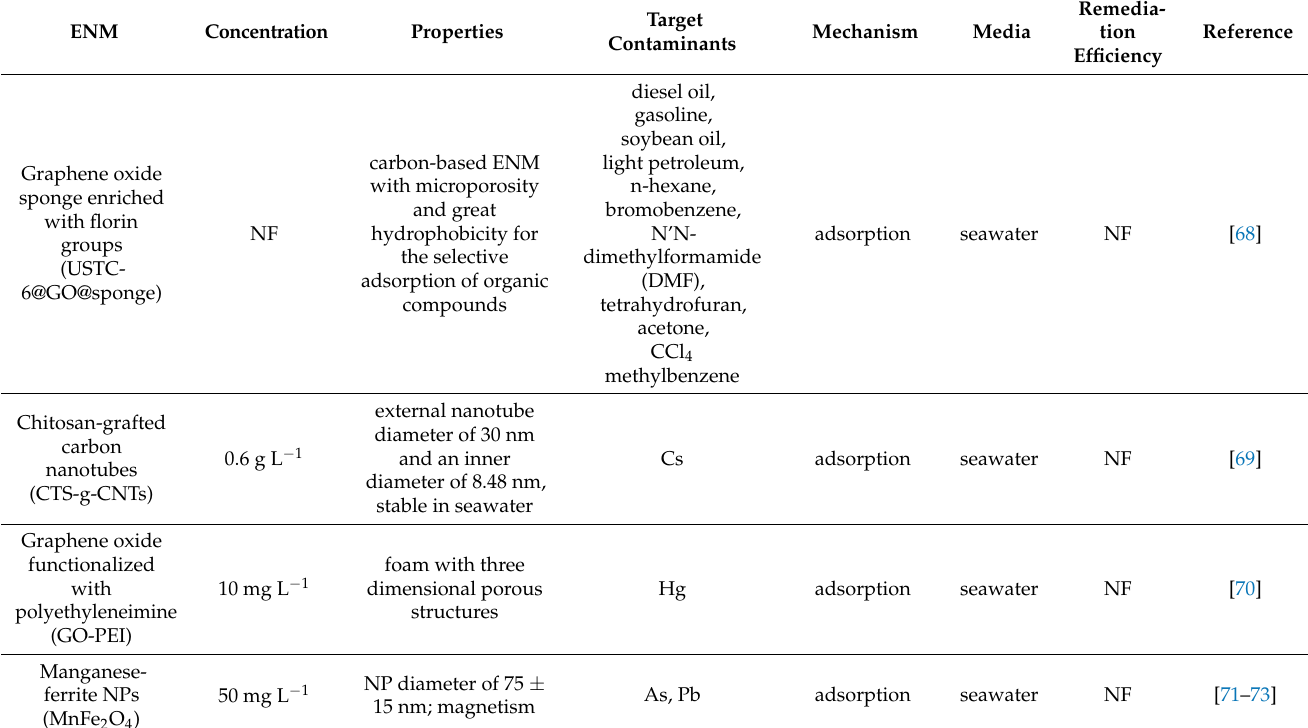
Table 1. ENMs synthetized for the remediation of marine